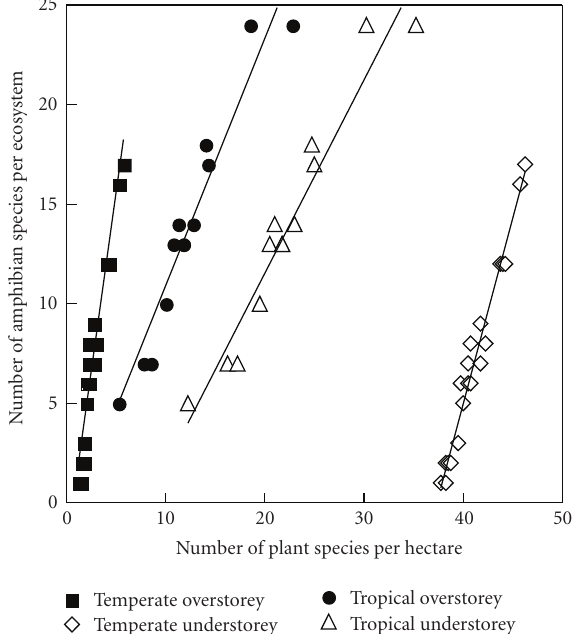
Figure 5: The relationship between species richness of overstorey and understorey plants in major plant communities with the biodiversity of Amphibia in associated wetlands in northern and southern Australia (Table 1). Temperate overstorey: Frogs = 3.59 plants − 2.81 ( n = 20; r 2 = 0 . 95). Temperate understorey: Frogs = 1.85 plants − 69.2 ( n = 20; r 2 = 0 . 97). Tropical overstorey: Frogs = 1.25 plants − 1.58( n = 13; r 2 = 0 . 93). Tropical understorey: Frogs = 0.97 plants − 7.85 ( n = 13; r 2 = 0 .